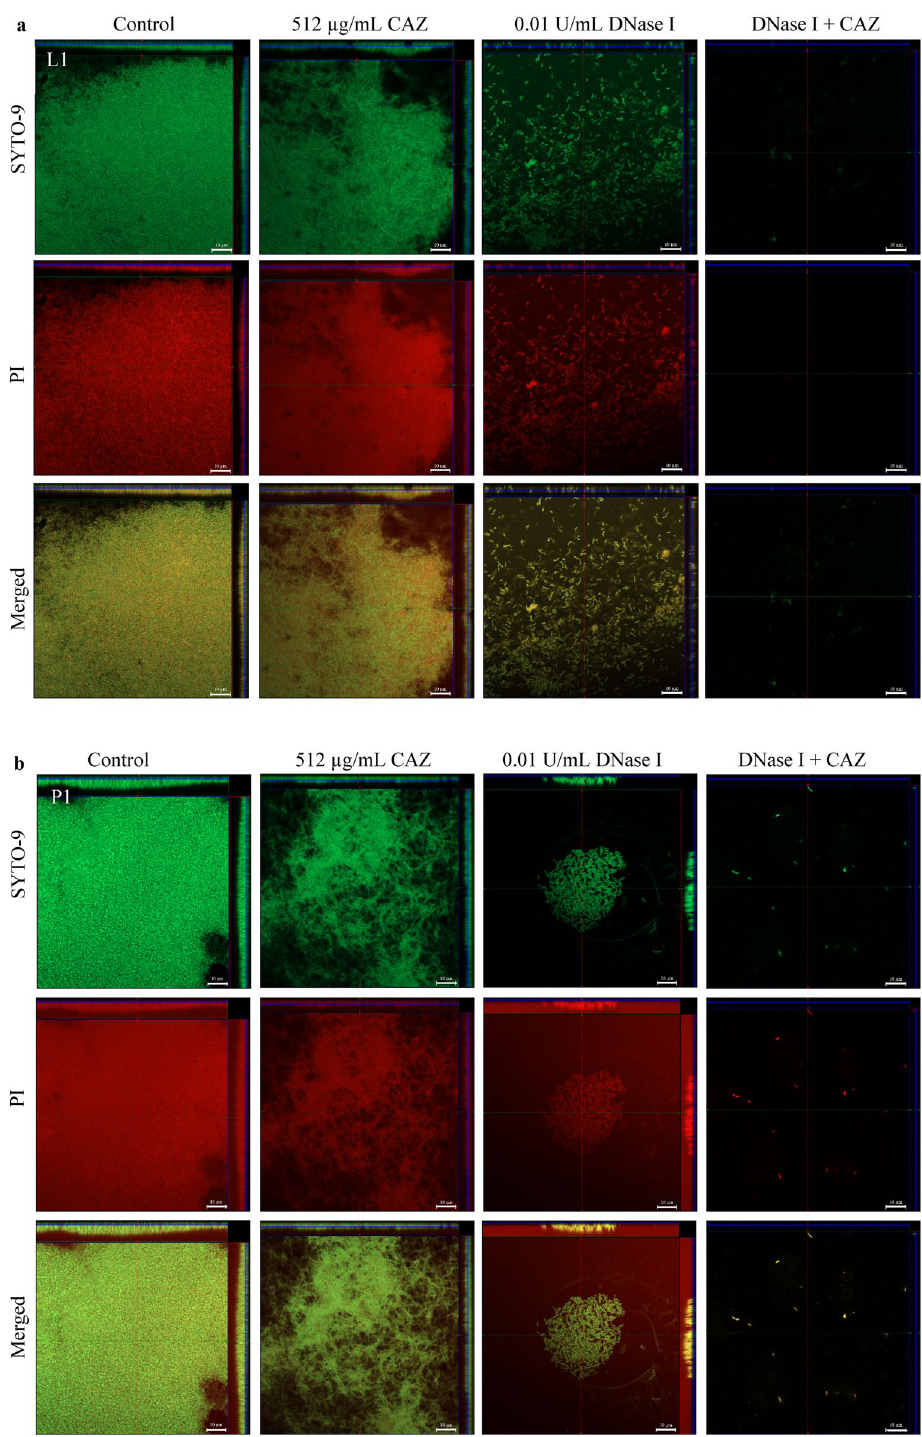
Figure 4. Live/dead images from CLSM of B. pseudomallei biofilm. The CLSM images of B. pseudomallei L1 ( a ), P1 ( b ) and H777 ( c ) biofilms grown statically on glass cover slips in LB broth before staining with 3.34 µM/ml SYTO-9 (live cell, green) and 5 µg/mL PI (dead, red). The biofilm was treated with LB (control), 0.01 U/ml DNase I, 512 µg/mL ceftazidime (CAZ), and DNase I combined with CAZ. These CLSM images are representatives of three independent experiments. The images were taken under a Zeiss 800 CLSM microscope (63 × magnification). Scale bar represents 10